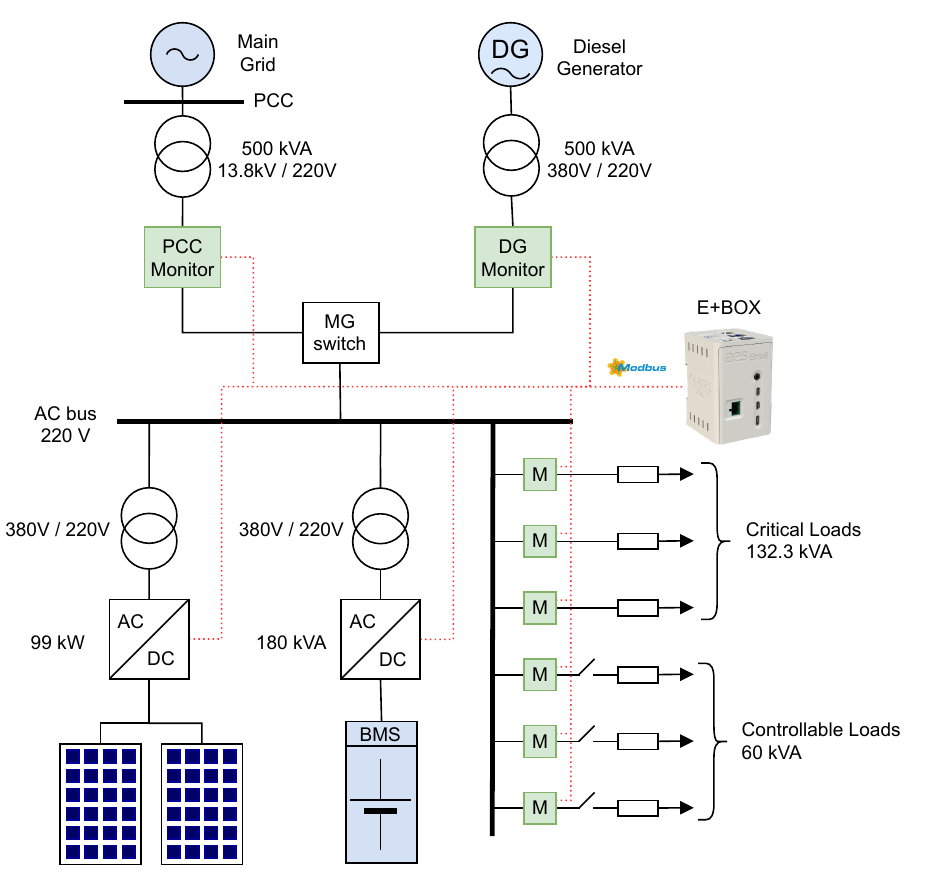
Figure 3. Simplified diagram of the COGE